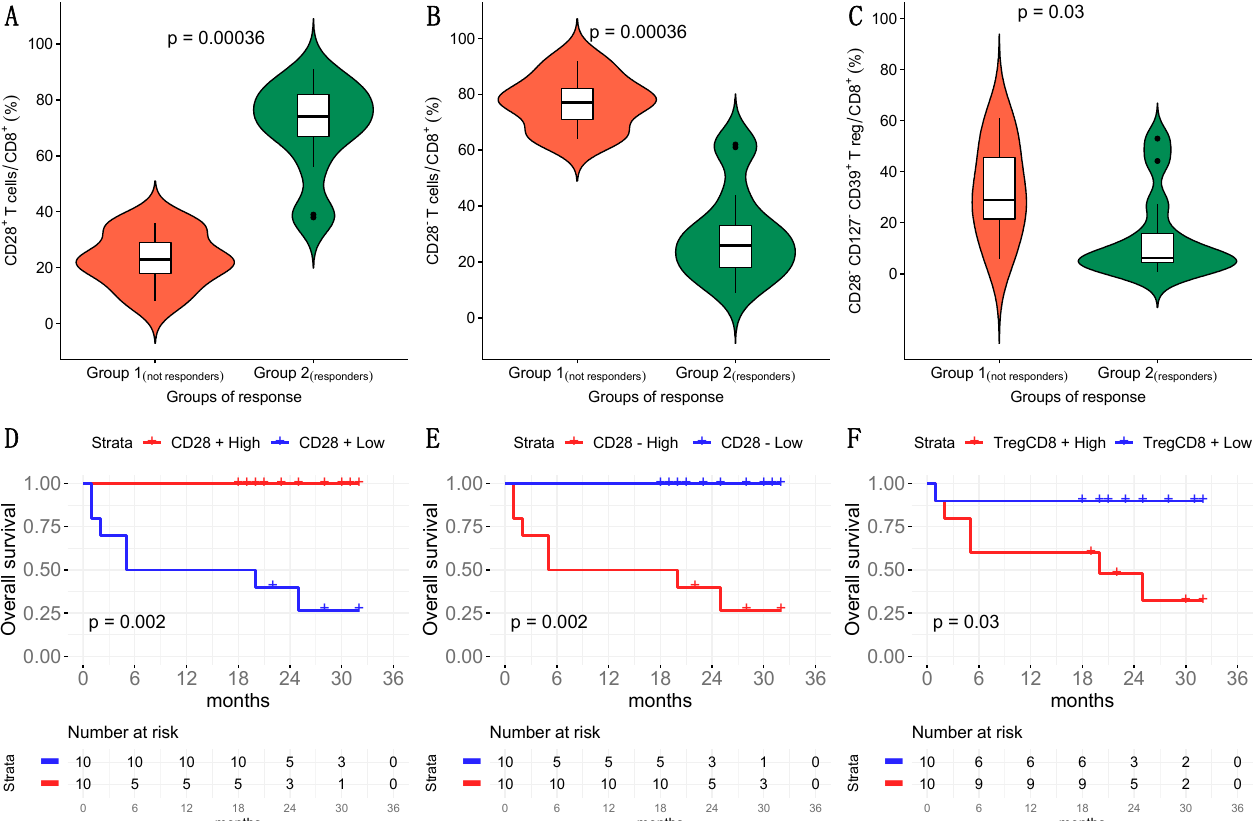
Figure 1. Frequency of tumor infiltrating CD8+CD28+ T cells, CD8+CD28 − T cells and CD8+CD28 − CD127 − CD39+ Treg from HNSCC patients. ( A – C ): Comparative analysis of the frequencies of CD8+CD28+ T cells (Panel A), CD8+CD28 − T cells (Panel B) and CD8+CD28 − CD127 − CD39+ Treg (Panel C) between Group 1 and Group 2 patients. ( D – F ): Survival of HNSCC patients divided into two groups based on the median (calculated in the overall population) of frequency of either CD8+CD28+ T lymphocytes (> or <47.5%) (Panel D), CD8+CD28 − T lymphocytes (> or <52.5%) (Panel E) or CD8+CD28 − CD127 − CD39+ Treg (> or <13.5%) (Panel F).